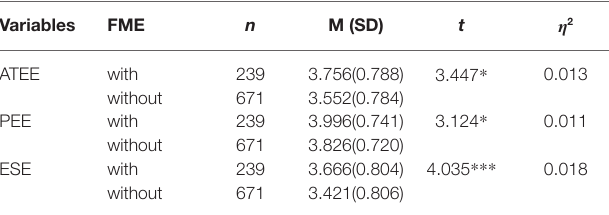
TABLE 4 | Descriptive information on variables of family members with or without entrepreneurial experience.